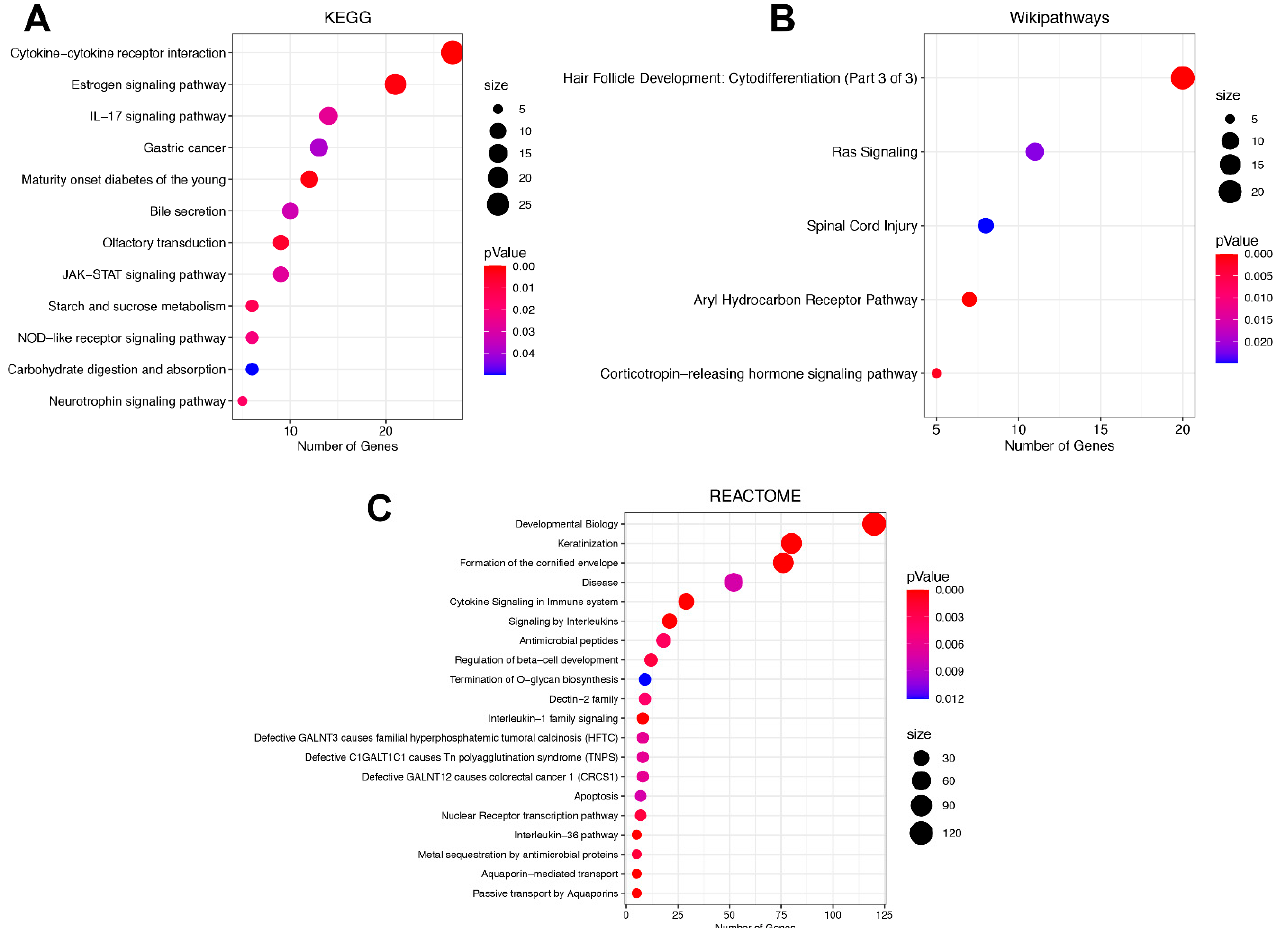
Figure 4. Signaling pathway enrichment analysis of DEGs between ADC and SCC patients per- formed with the WebGestalt platform. ( A ) Enriched pathways in the KEGG database analysis. ( B ) Enriched pathways in the WikiPathways database analysis. ( C ) Enriched pathways in the Reactome database analysis. The size of the dots represents the number of DEGs in the pathway, while the dot color represents the significance of the analysis, where red shows a more significantly enriched